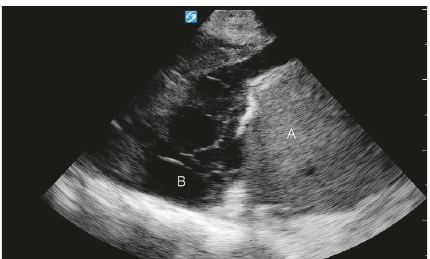
Figure 5: Chest US approximately 8 hours after thoracentesis demonstrating complex pleural fluid with septations and debris (B). A =